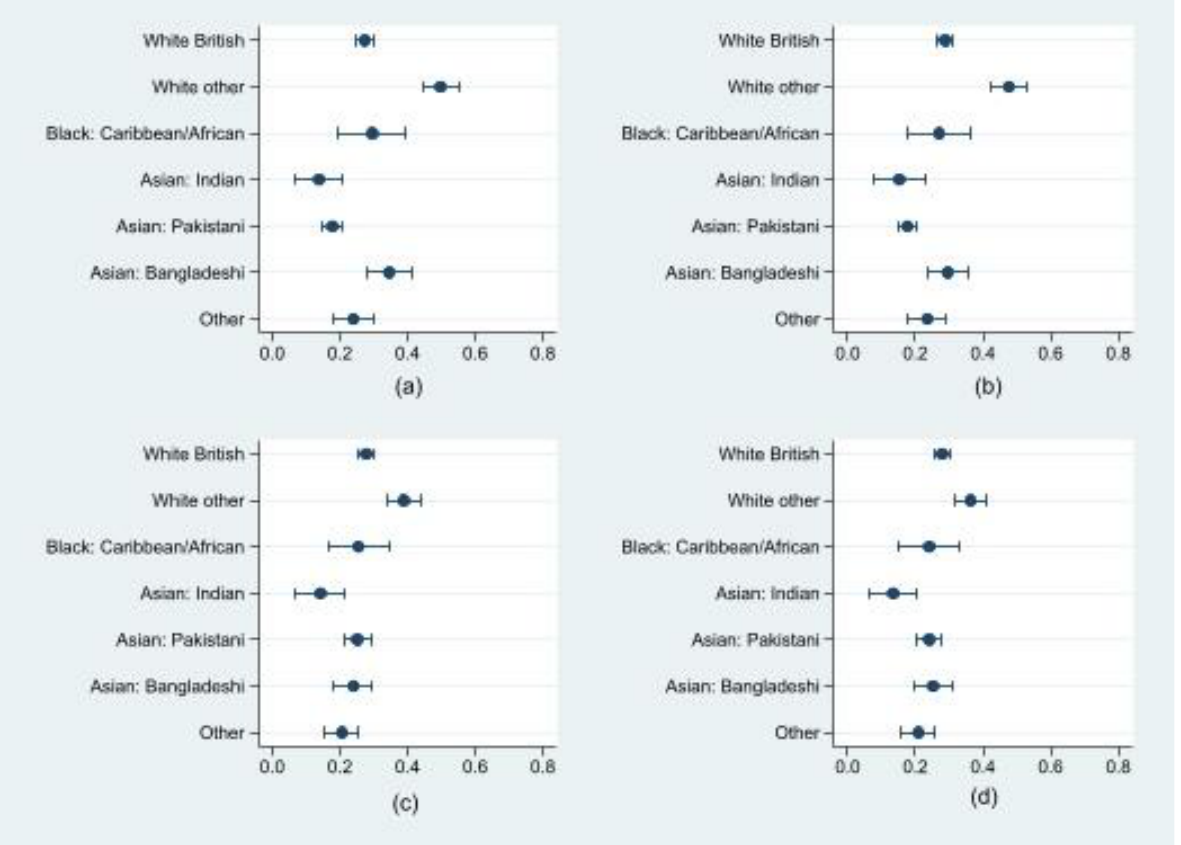
Figure 2. Predictive probability of clinically important depressive symptoms by ethnicity ( n = 2807); ( a ) unadjusted model for the association between ethnicity and depressive symptoms; ( b ) regression model for the association between ethnicity and depressive symptoms adjusted for financial insecurity (secure (ref), insecure); ( c ) regression model for the association between ethnicity and depressive symptoms adjusted for location of residency (Bradford (ref), London) and financial insecurity (secure (ref), insecure) and interaction between ethnicity and financial insecurity; ( d ) regression model for the association between ethnicity and depressive symptoms adjusted for location of residency (Bradford (ref), London), financial insecurity (secure (ref), insecure), social support (high (ref), medium, low), and interactions between ethnicity and financial insecurity, and ethnicity and social support.